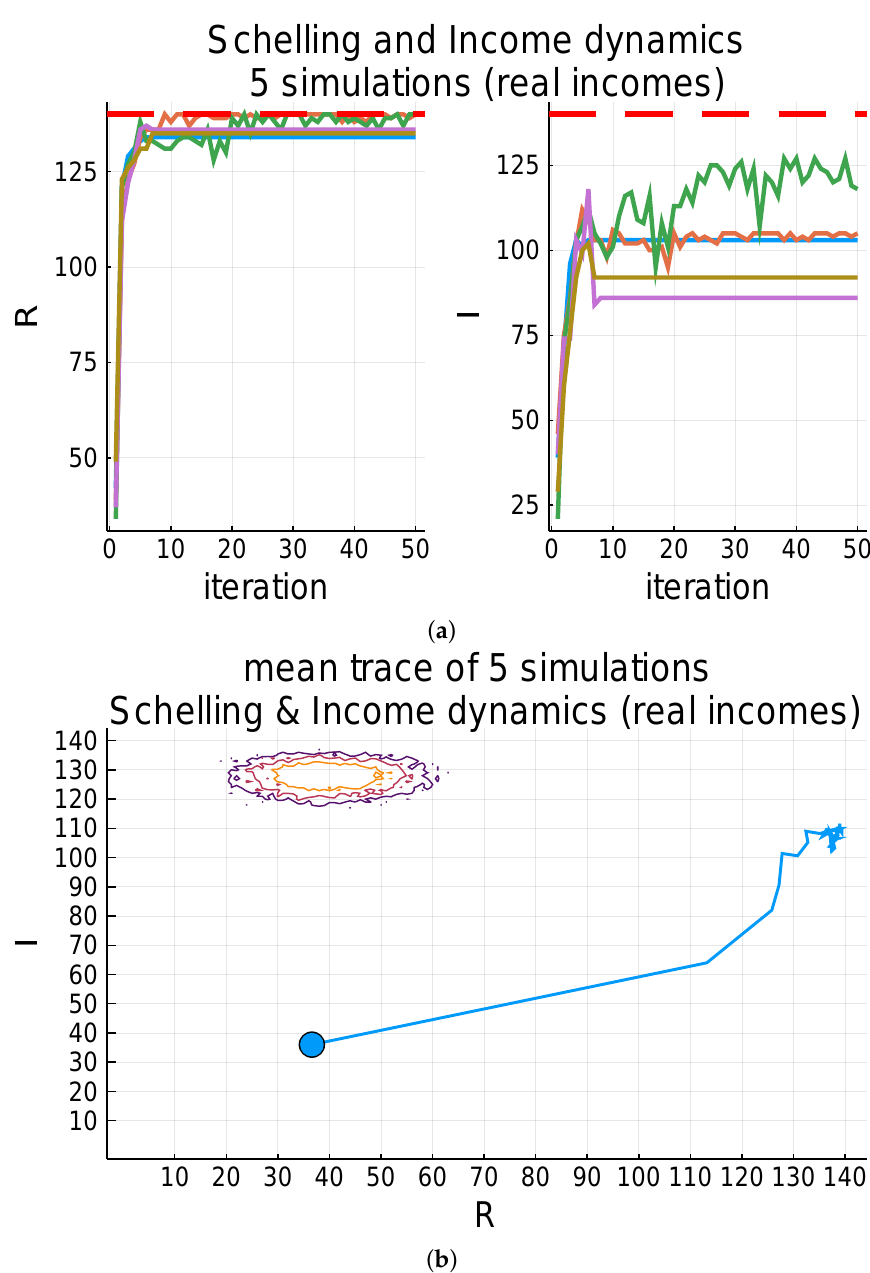
Figure 5. A higher increase of the income homogeneity is presented due to the increased spending of the upper incomes. Subfigure ( a ) shows the trajectory of the overall grid homogeneity over simulation iterations for R and the grid income homogeneity I for the same iterations. Subfigure ( b ) shows the trajectory over both homogeneity variables with the contour levels of the sampled density of the space used to calculate the entropy of each point in the trajectory. Equation (10) was used for residential